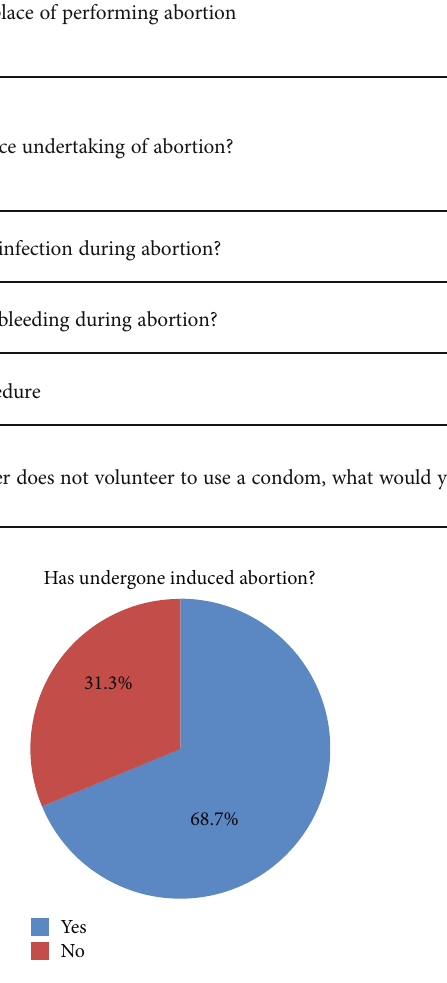
Figure 1: Magnitude of induced abortion of female students at Hawassa University, SNNPR, Ethiopia, April